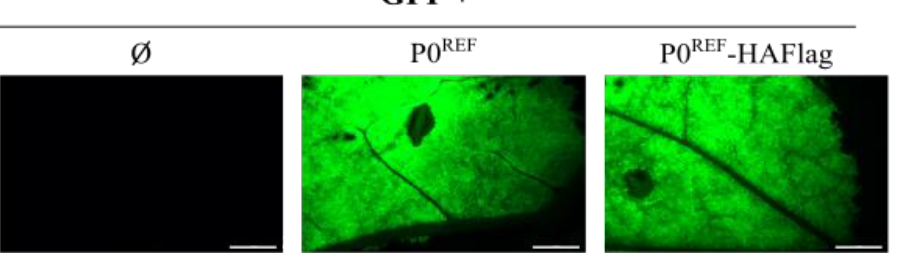
Figure 2. Corroboration of the preservation of VSR activity in a HAFlag-tagged PeVYV-5 P0 REF . N. benthamiana leaves were agroinfiltrated with the construct for expression of GFP either alone (Ø) or in combination with constructs directing expression of PeVYV-5 P0 REF or PeVYV-5 P0 REF - HAFlag. Pictures show GFP fluorescence in agroinfiltrated leaf patches at 10 dpif. The inset scale bar sponds to 5 mm in all panels. corresponds to 5 mm in all panels.